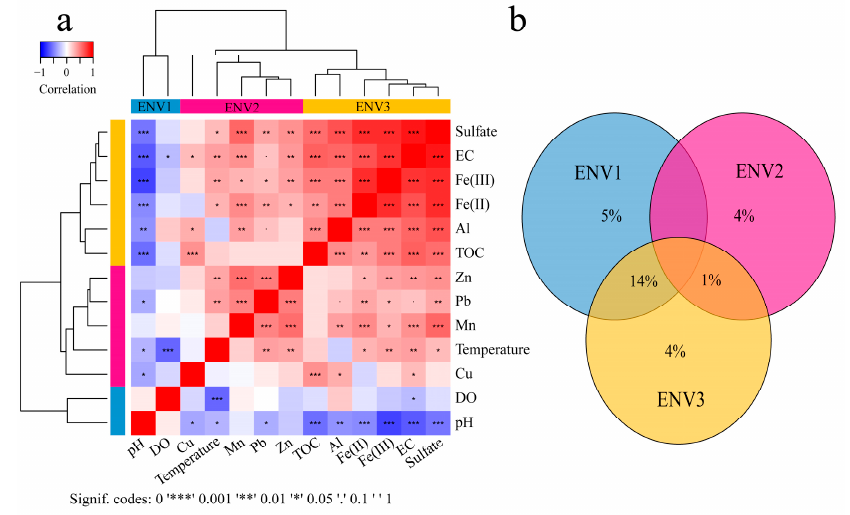
Figure 3. Hierarchical cluster analysis ( a ) of correlations between different environmental variations and distance-based variance partitioning analysis ( b ) of AMD microbial communities related to the three environmental properties derived from the clustering analysis (data from [24,29]).